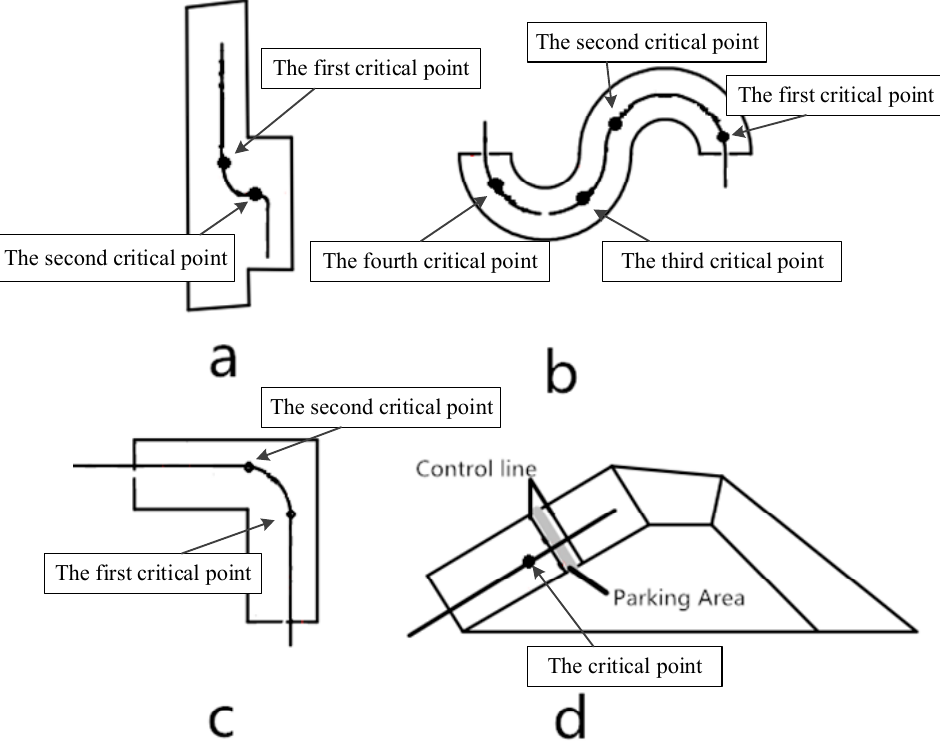
Figure 18. The critical points of the rotating steering wheel in the remaining four subjects (a) the critical point of Parallel parking; and ( b ) the critical point of Tortuous route; and ( c ) the critical point of the Quarter turn, and ( d ) the critical point of Ramp parking.